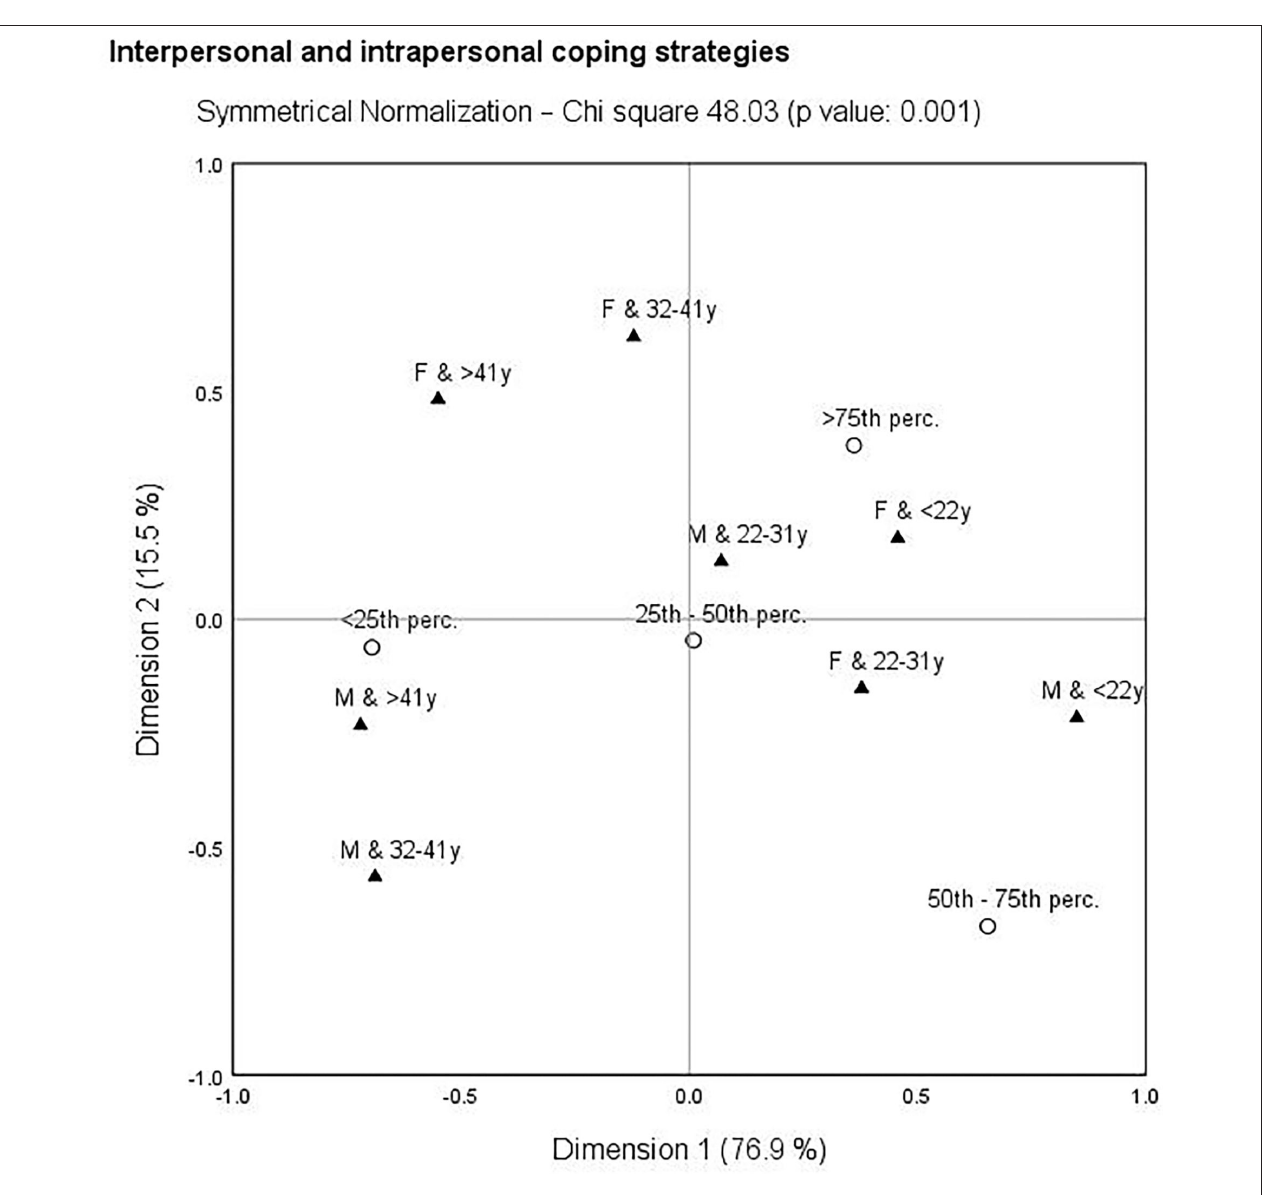
FIGURE 4 | Correspondence map—interpersonal and intrapersonal coping strategies (IICS) and gender-age characteristics.